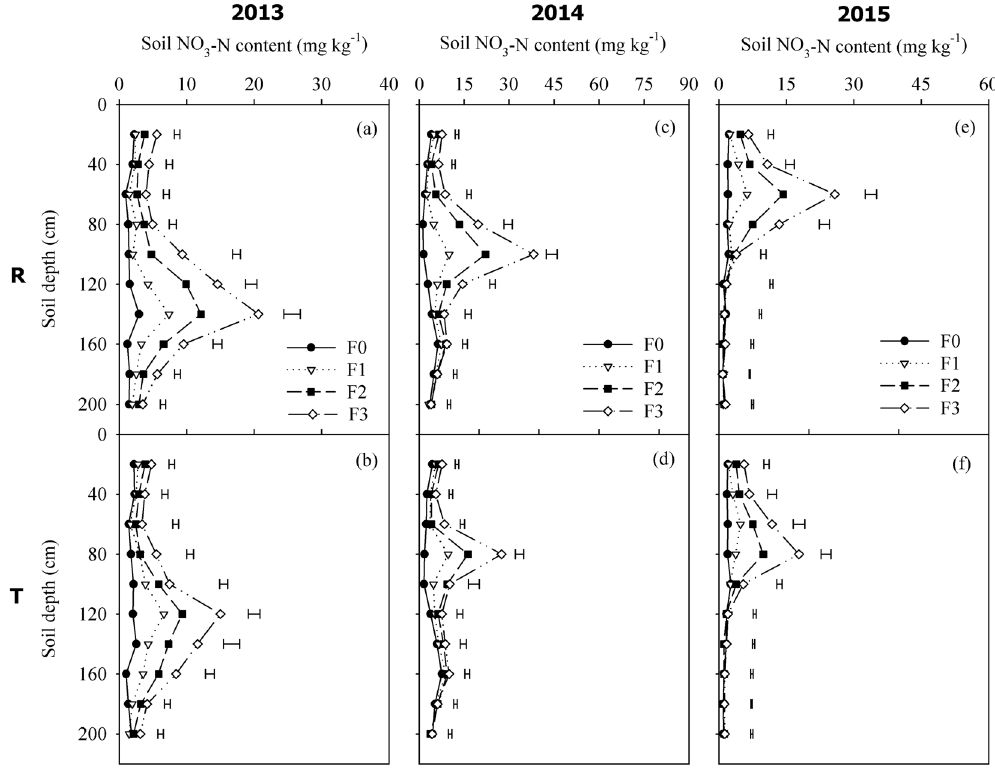
Figure 3. Soil NO 3 -N content at harvesting in the 0–200 cm soil layers according to the four fertilizer rates under two planting patterns during 2013–2015. Note: R = ridge and furrow rainfall harvesting planting; T = traditional flat planting; F0, F1, F2, and F3 represent N:P at 0:0, 93:48, 186:96, and 279:144 kg ha − 1 , respectively. Horizontal bars represent the LSD values at the P = 0.05